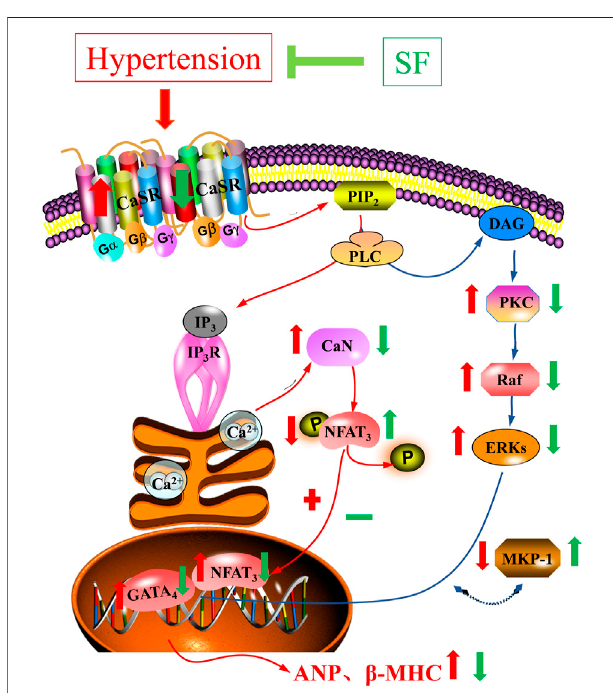
FIGURE 8 | Schematic diagram of the mechanism underlying inhibition of cardiac hypertrophy by SF in SHRs.